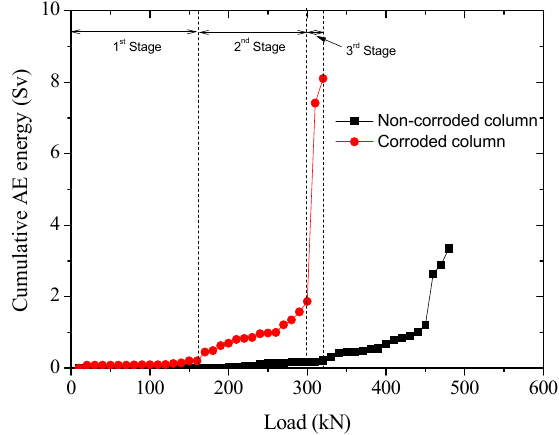
Figure 16. Correlation between AE cumulative energy and loads.